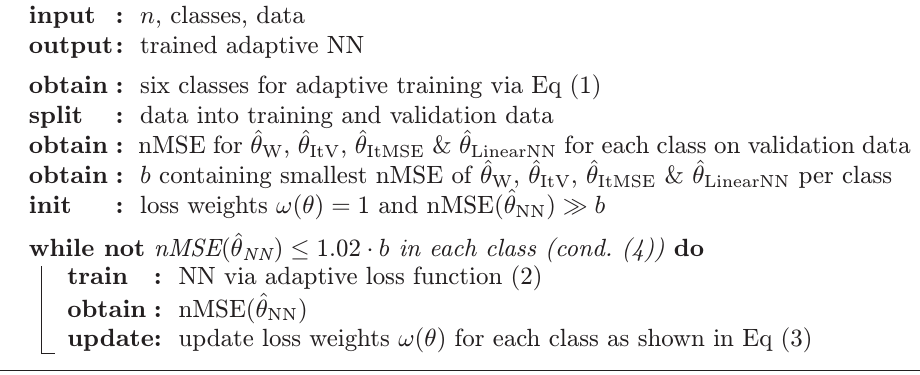
Algorithm 1: Overview on adaptive training procedure. This pseudocode illustrates the basic principle of the adaptive training procedure used for the adaptive neural